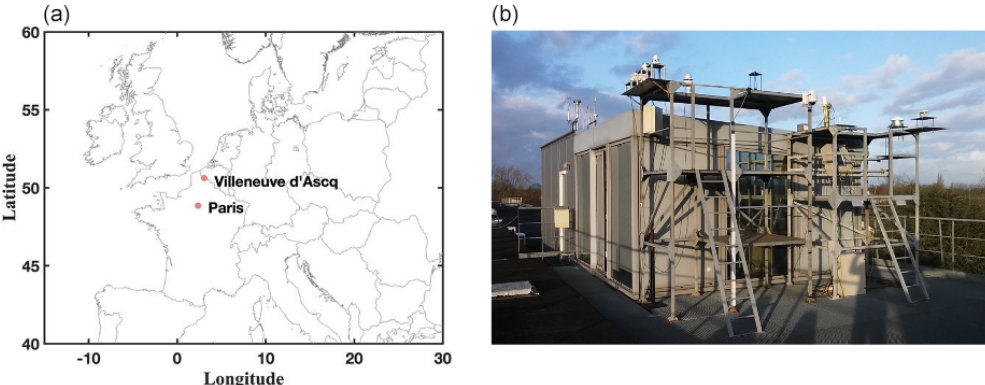
Figure 1. ATOLL location in Villeneuve-d’Ascq (northern France), and a picture of the station on the rooftop of the University of Lille P5 building